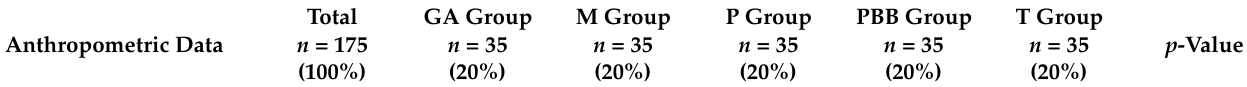
Table 1. Anthropometric data of the patients in the studied